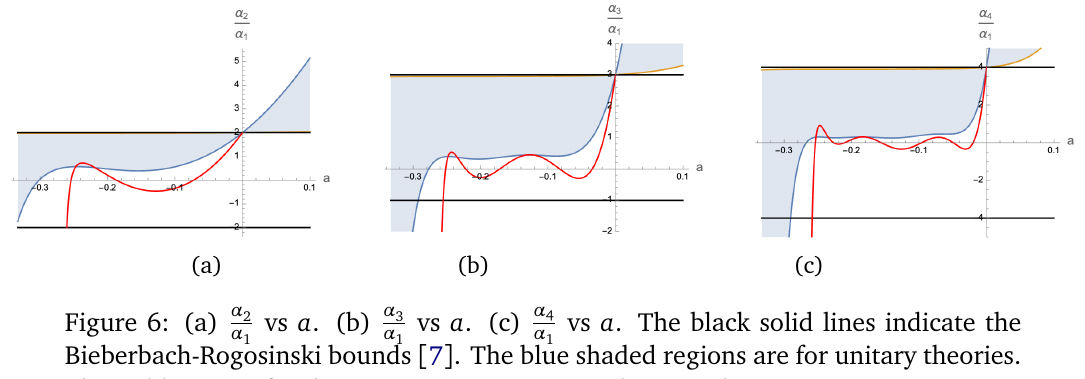
Figure 6: (a) Bieberbach-Rogosinski bounds [ 7 ] . The blue shaded regions are for unitary theories. The red lines are for the non-unitary Yang-Lee edge